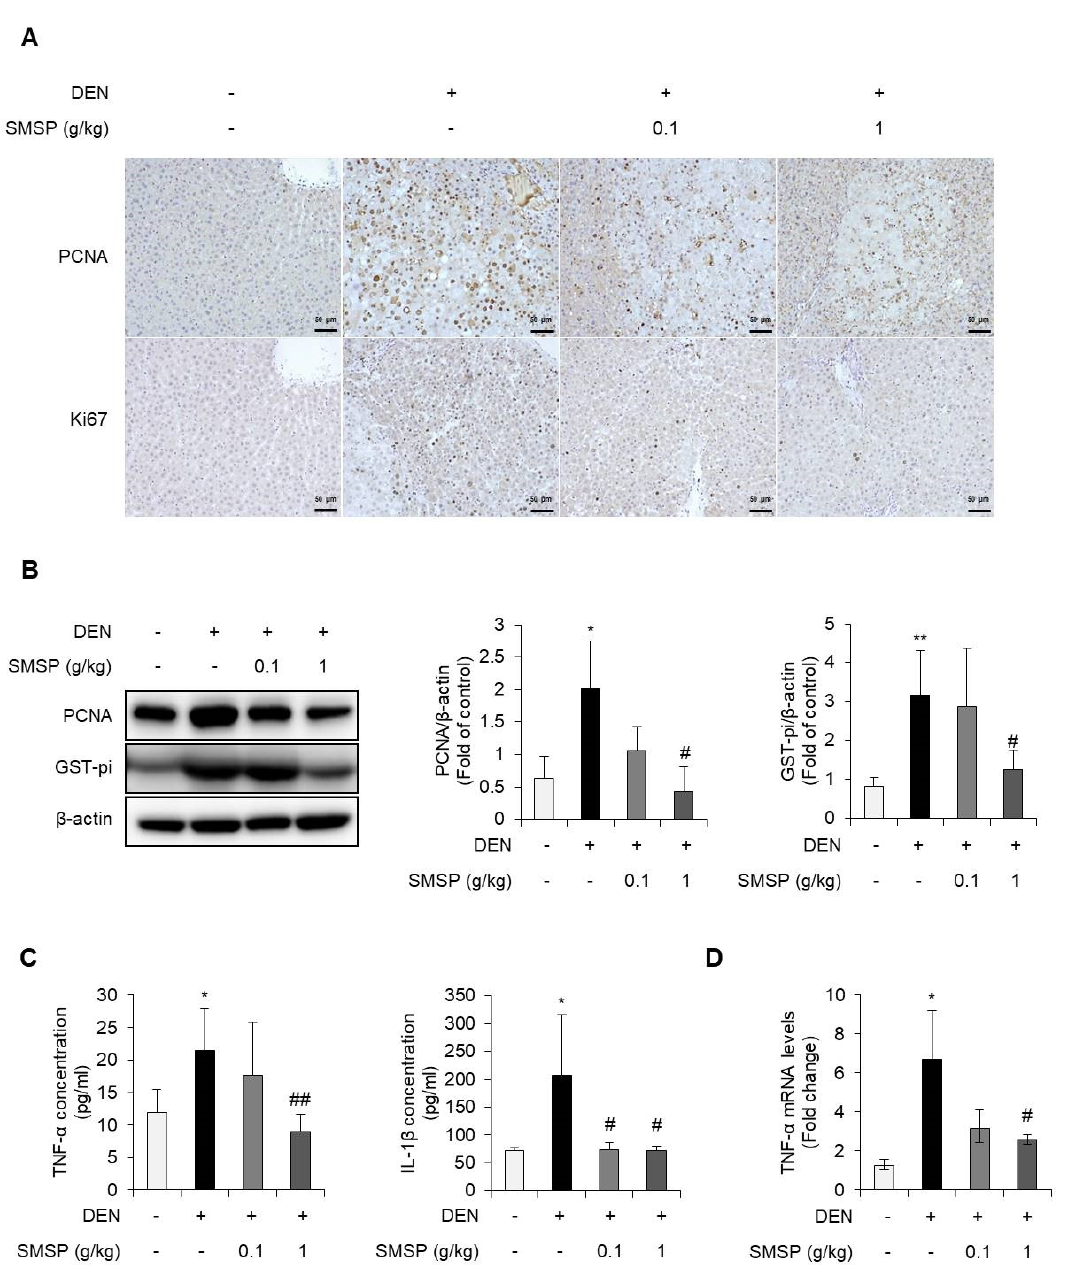
Figure 3. SMSP decreases hepatic proliferation and inflammation in rats treated with DEN for 16 weeks. ( A ) Representative immunohistochemical pictures of proliferating cell nuclear antigen (PCNA) or Ki67 in rats. ( B ) Hepatic PCNA and GST-pi protein expressions were determined by Western blot analysis. Quantification of each protein expression relative to control group was exhibited. Data shown as mean ± SD. ( C ) Serum levels of pro-inflammatory cytokines, tumor necrosis factor-alpha (TNF- α ) and interleukin-1 β (IL-1 β ) were measured by enzyme-linked immunosorbent assay (ELISA). ( D ) The hepatic expression of TNF- α was measured by quantitative real-time polymerase chain reaction (qRT-PCR). Statistical significance was analyzed by ANOVA. * p < 0.05 and ** p < 0.01 compared to control; # p < 0.05 and ## p < 0.01 compared to the DEN group.